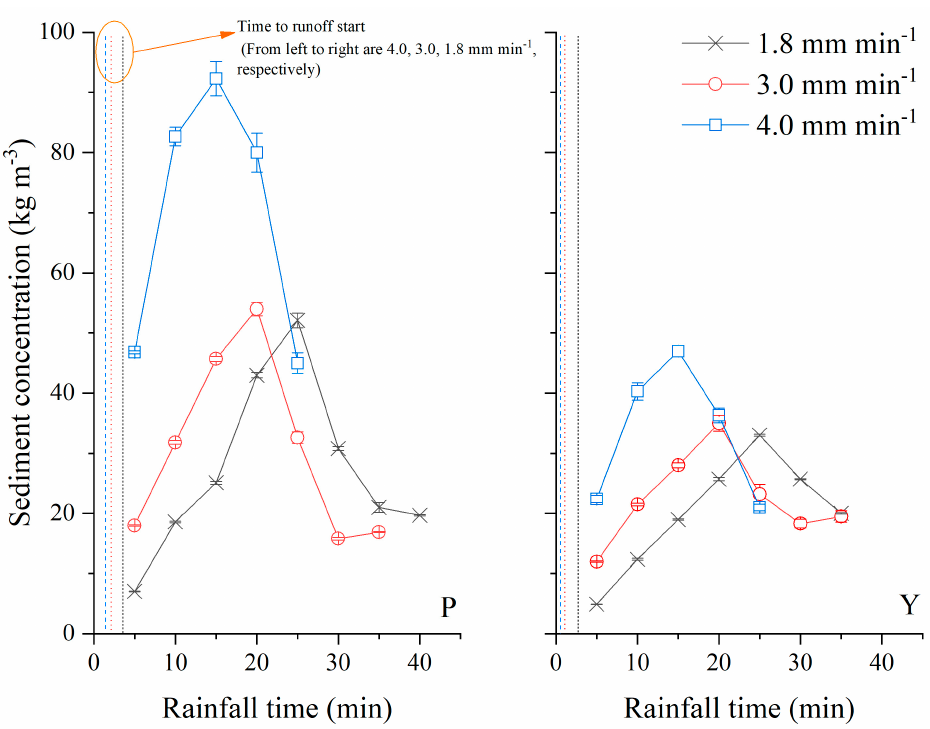
Figure 3. Sediment concentration in runoff with rainfall time under different rainfall intensities at slope 15° (P represents purple soil, Y represents yellow soil).